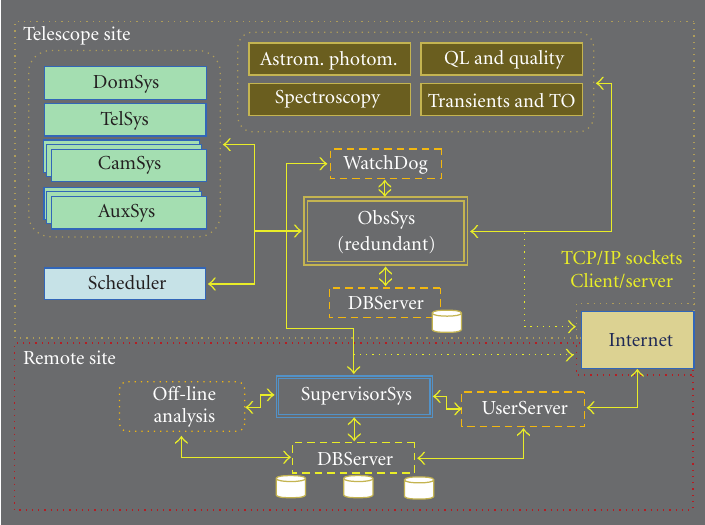
Figure 16: A schematic view of the control s/w and DMS.